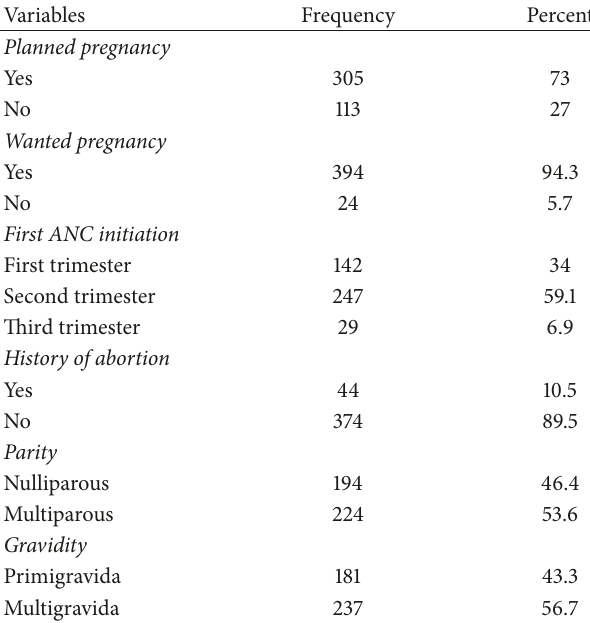
Table 2: Obstetrics related characteristics of participants in Gondar town, 2015 (𝑛 = 418)